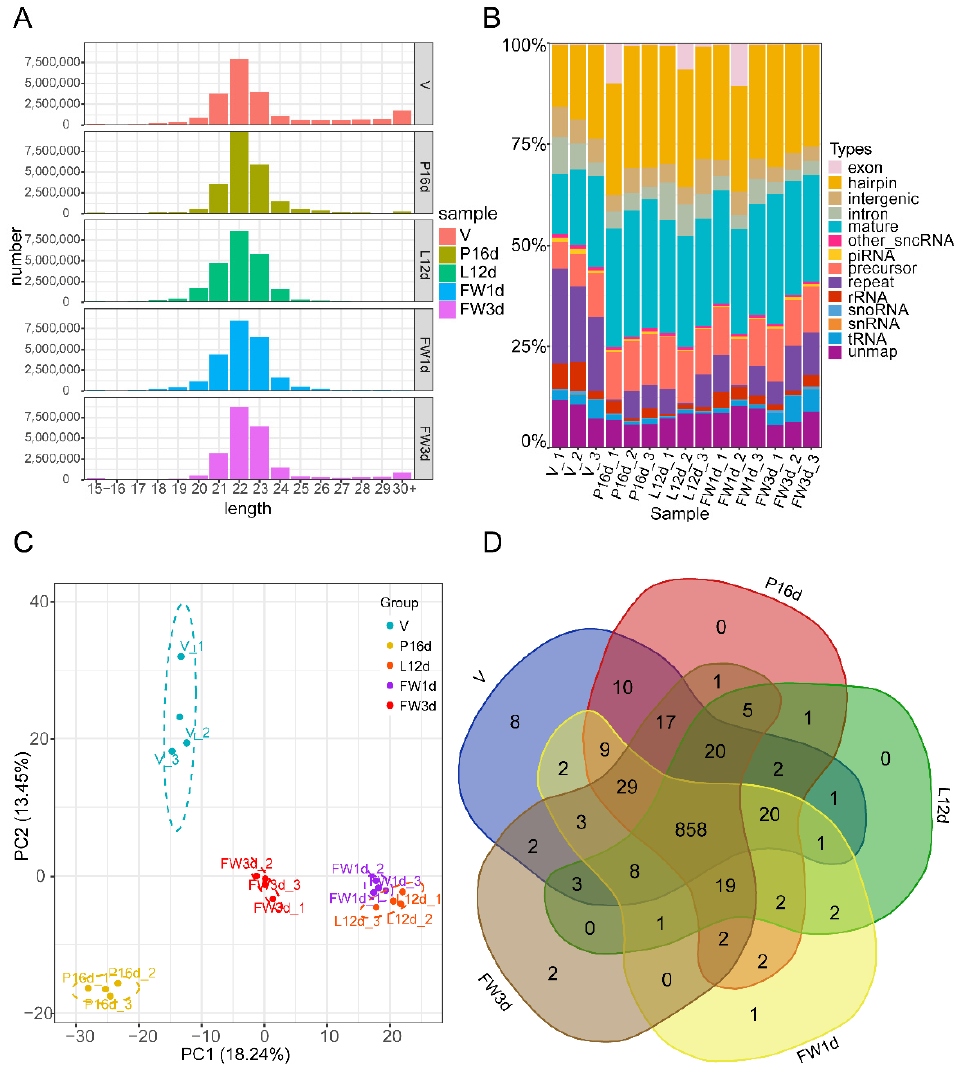
Figure 1. Overview of the small RNA sequencing data: ( A ) Distribution of total identified small RNAs’ lengths. ( B ) Classification of all detected small RNAs. ( C ) Principal component analysis of the total identified miRNAs. ( D ) Venn diagram illustrating the overlap of miRNAs across five different stages.